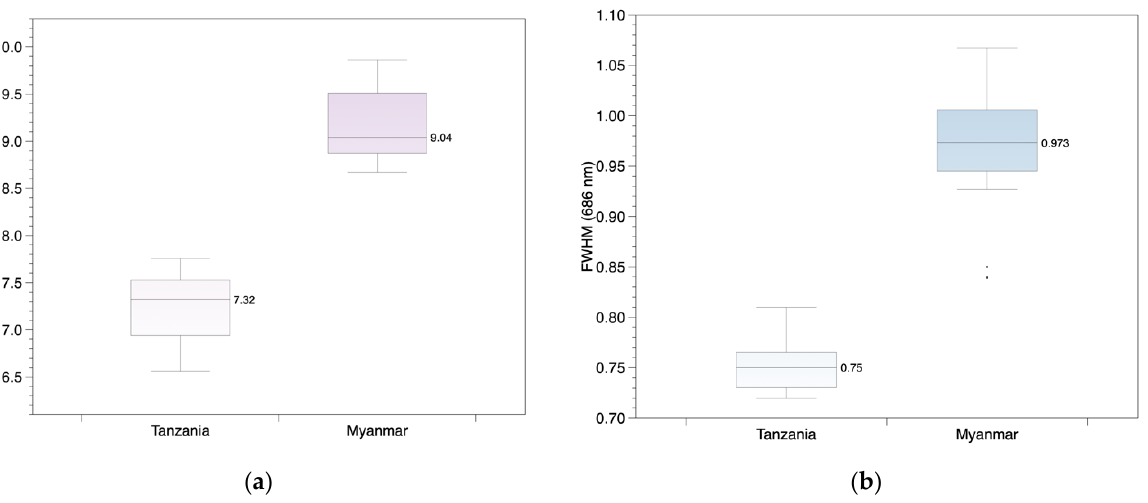
Figure 21. ( a ) The FWHM of the 406 cm − 1 peak in the Raman spectrum in spinels from Tanzania and Myanmar. The values of the former are distinctly lower than those of the latter, with no overlapping. ( b ) The FWHM of the 686 nm peak in the PL spectrum in spinels from Tanzania and Myanmar.